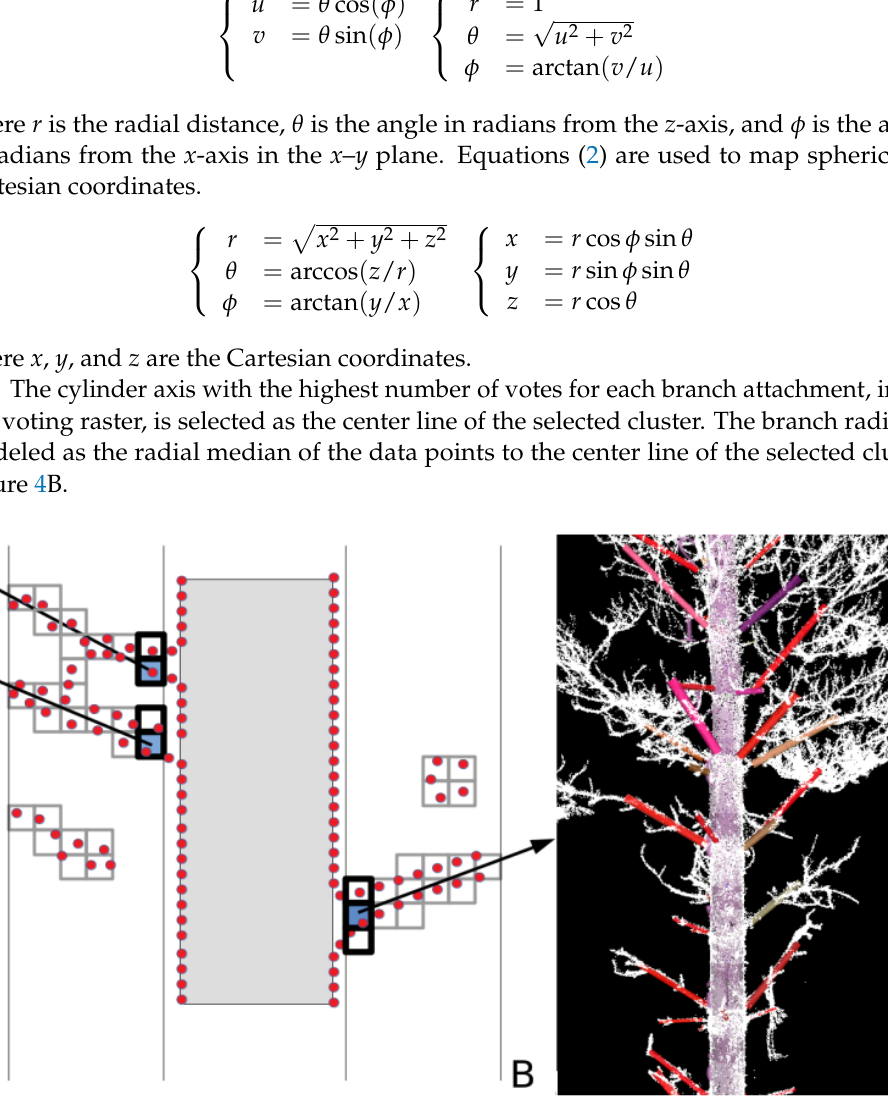
Figure 4. ( A ) Sketch of the branch detection algorithm. Laser data as red dots, stem profile as a large grey rectangle, near stem zone marked with thin lines, 3D cluster cells as small squares, stem attachment cells as black squares, selected start cell for branch detection in blue, estimated stem axes as arrows. ( B ) Estimated branch attachments to pine in the field data were measured with a terrestrial laser scanner. White dots are laser data. Red cylinders are the branch attachment estimates. The weakly colored cylinders are the stem profile